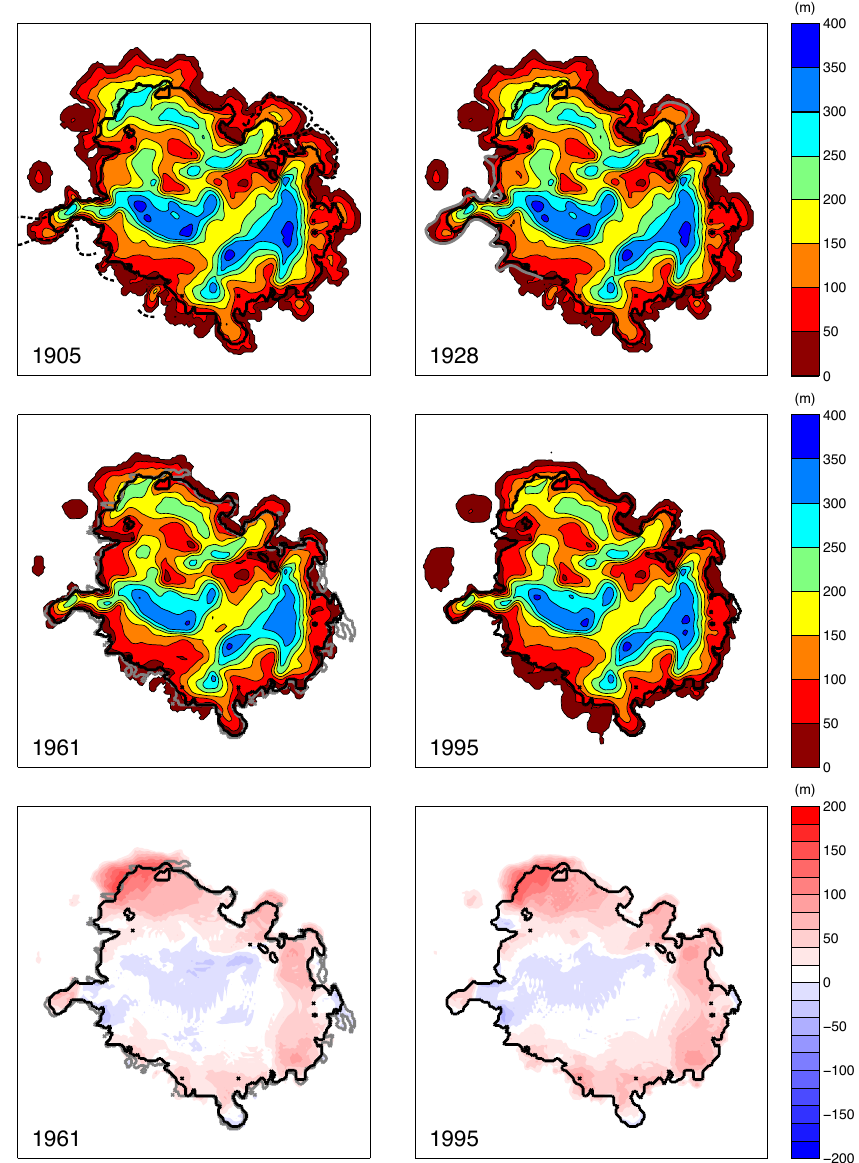
Fig. 9. Modelled ice thickness for 1905, 1928, 1961 and 1995. Contour lines are drawn for 50m intervals. The lower two panels show the difference between the surface elevation modelled for 1961 and 1995 and the DEMs for these two years, with 20m intervals. In all panels, the thick line represents the present-day ice cap margin. The dashed line in the panel for 1905 represents the LIA extent, also shown in Fig. 2. For 1928 and 1961, the contemporary ice margin is indicated by a grey line. For 1928, this is the 1928 margin around Rembesdalsskåka and the 1934 margin around Midtdalsbreen. References are given in the